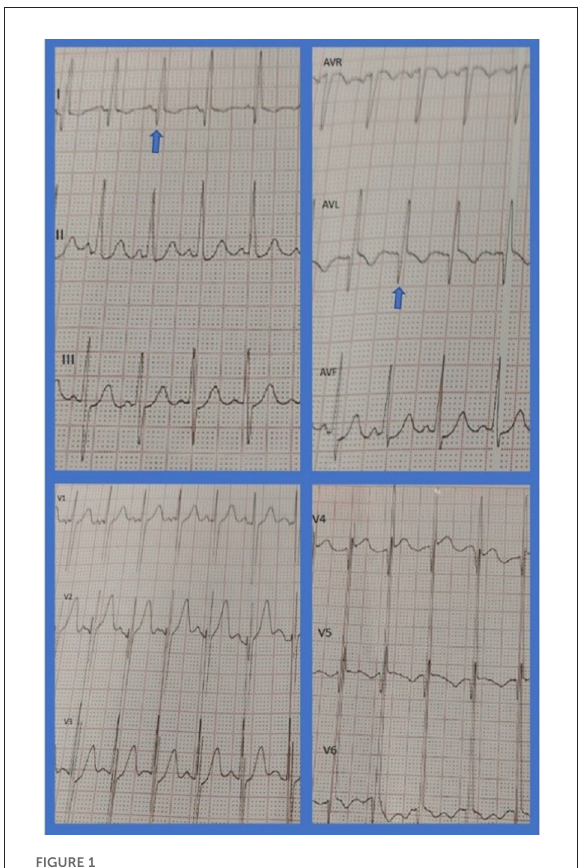
FIGURE1 ECG demonstrating sinus tachycardia, pathologic Q waves in leads I, AVL, and